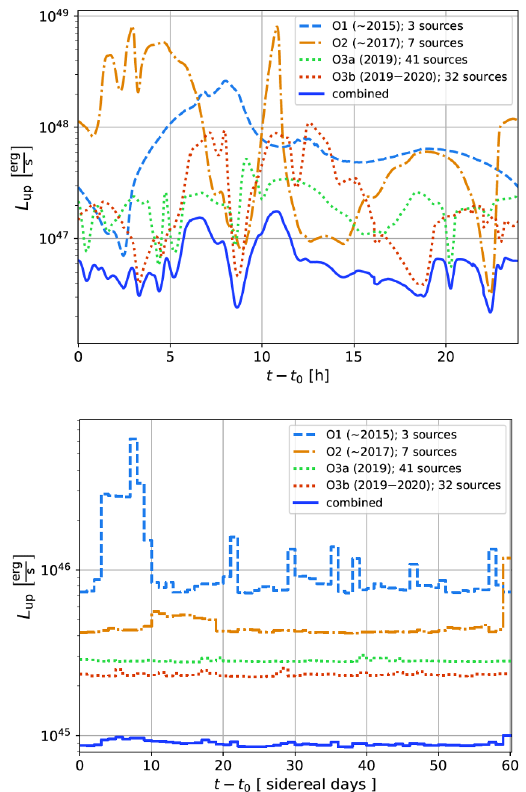
Figure 7. Solid line: upper limit (90% C.L.) on the time- dependent universal isotropic neutrino luminosity for the 24 hour (top) or the 60-day (bottom) follow-up period; other lines: con- tributions from individual LIGO / Virgo observational runs [16].